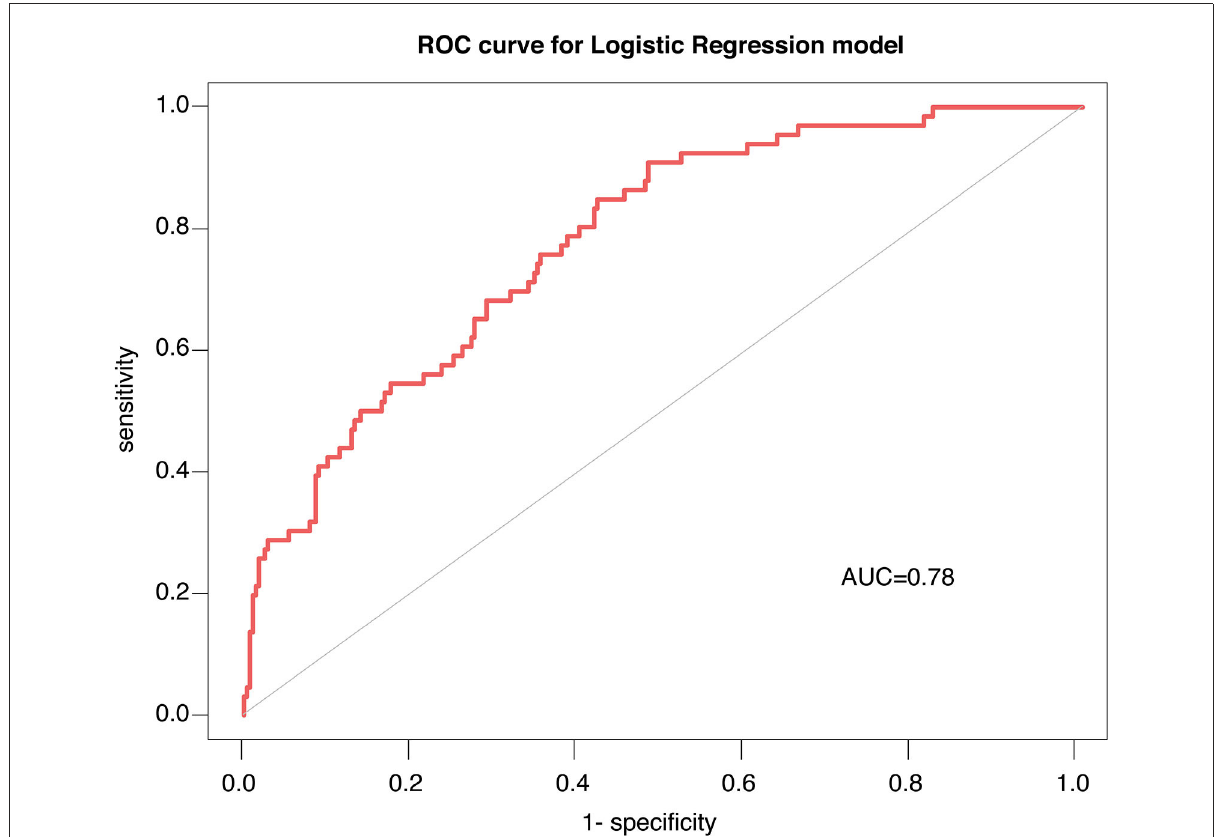
FIGURE3 Receiver operating characteristic curve (ROC) analysis for the